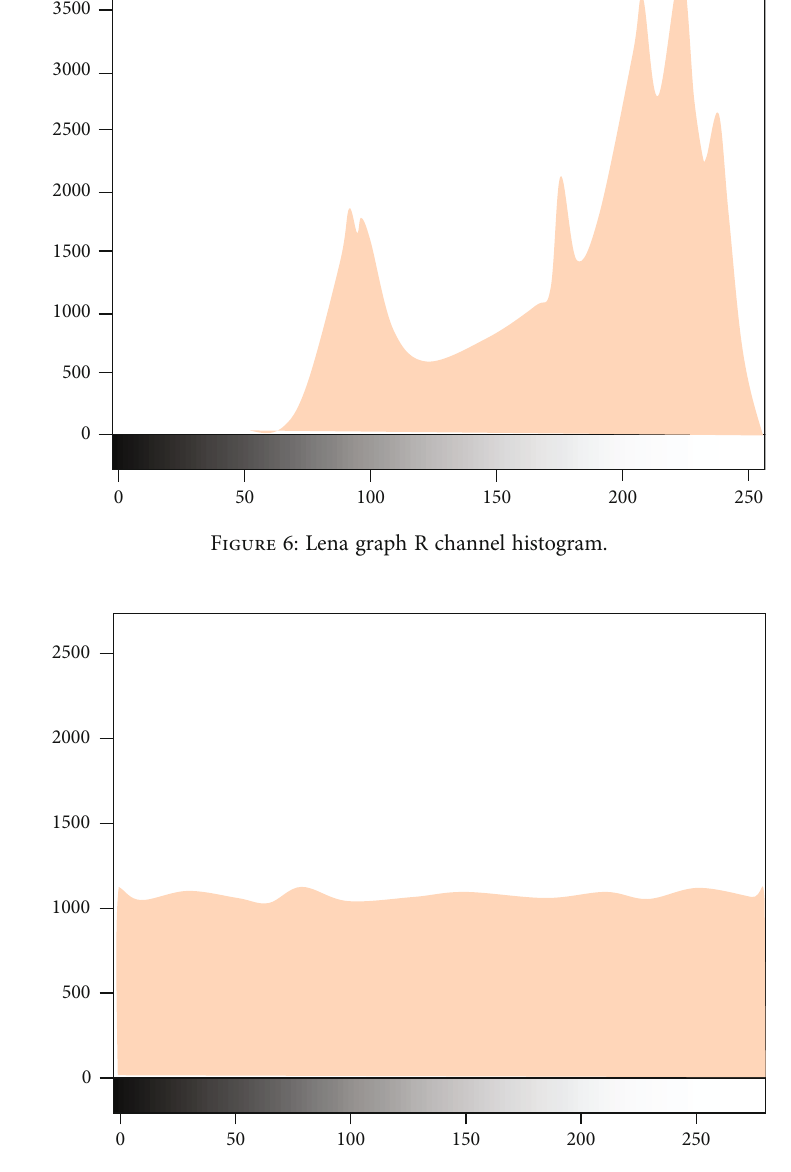
Figure 7: Histogram of ciphertext R